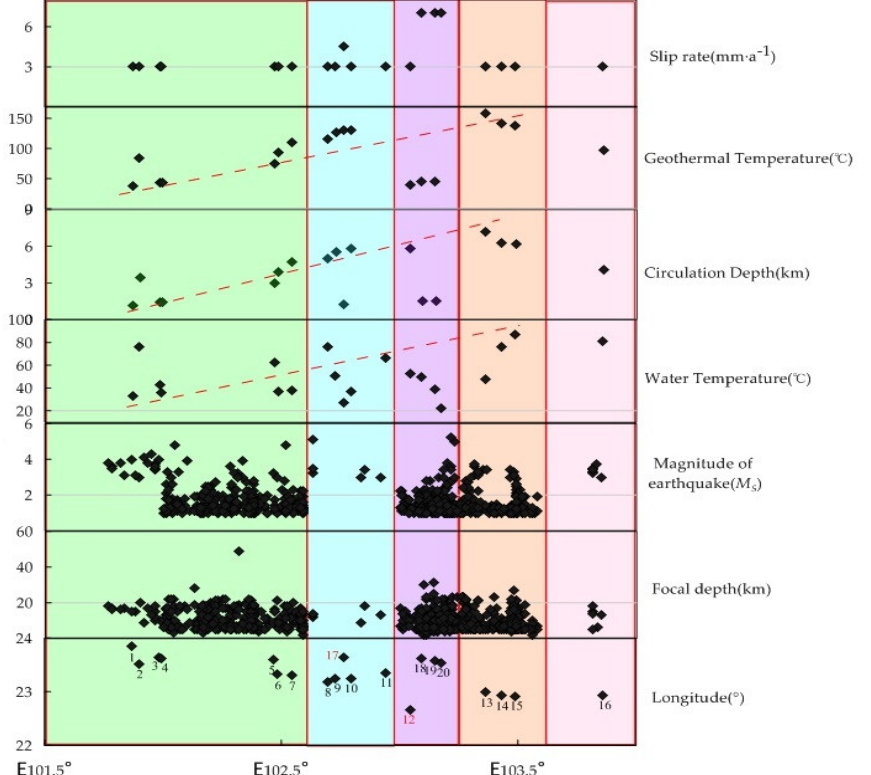
Figure 13. The spatial distribution of temperature, circulation depth, slip rate, magnitude, and focal depth at the intersection of the RRF and the XJF were studied. In order of longitude, from west to east, green is S1–S7 (RRF), blue is S8–S11 (RRF), rose is S18–S20 (XJF), orange is S13–S15 (RRF), and pink is S16 (RRF). S17 is the intersection of the JSF and the XJF, S12 is in the DDFF, and S16 is in the MZ-NXHF, so this figure is not discussed. Earthquake time ranged from 1 January 2014